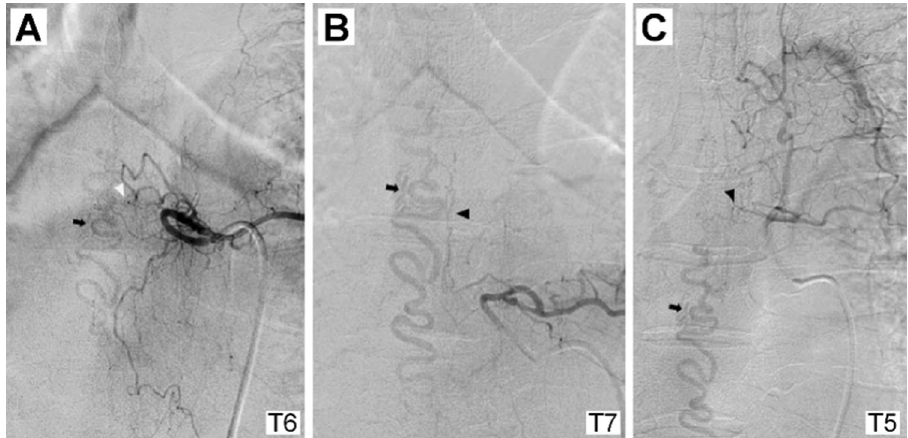
Figure 1. A case of thoracic dural arteriovenous fistula at the T6 level with multiple feeders was defined in the present study. ( A ) Angiogram of the left T6 segmental artery demonstrating the main arterial feeder of the radiculomeningeal artery (white arrowhead) arising from the left T6 segmental artery connected to the engorged perimedullary vein (arrow). ( B ) and ( C ) show engorgement of the perimedullary vein (arrow) after visualization of the dural arteriovenous fistula by collateral channels (black arrowheads) on the angiograms of the left T7 and T5 segmental arteries.